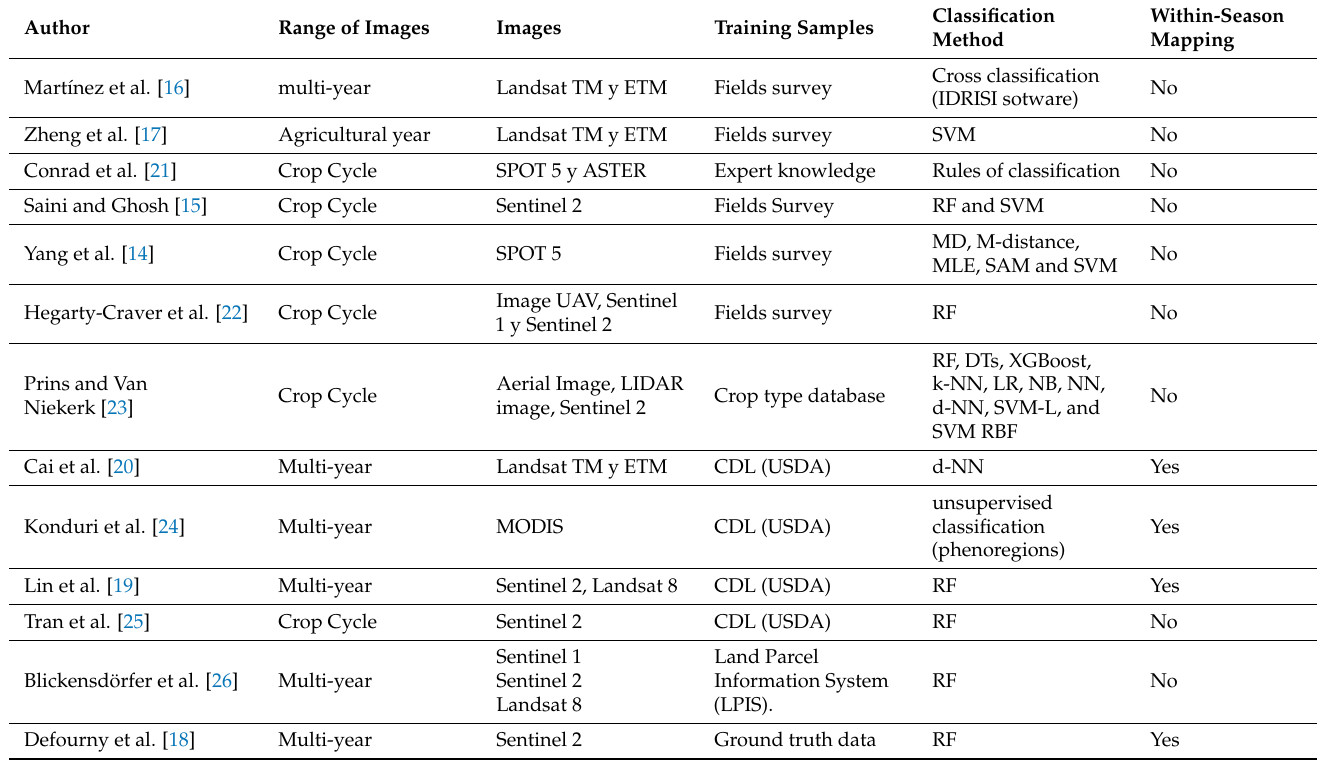
Table 1. Some methodologies and techniques applied to crop